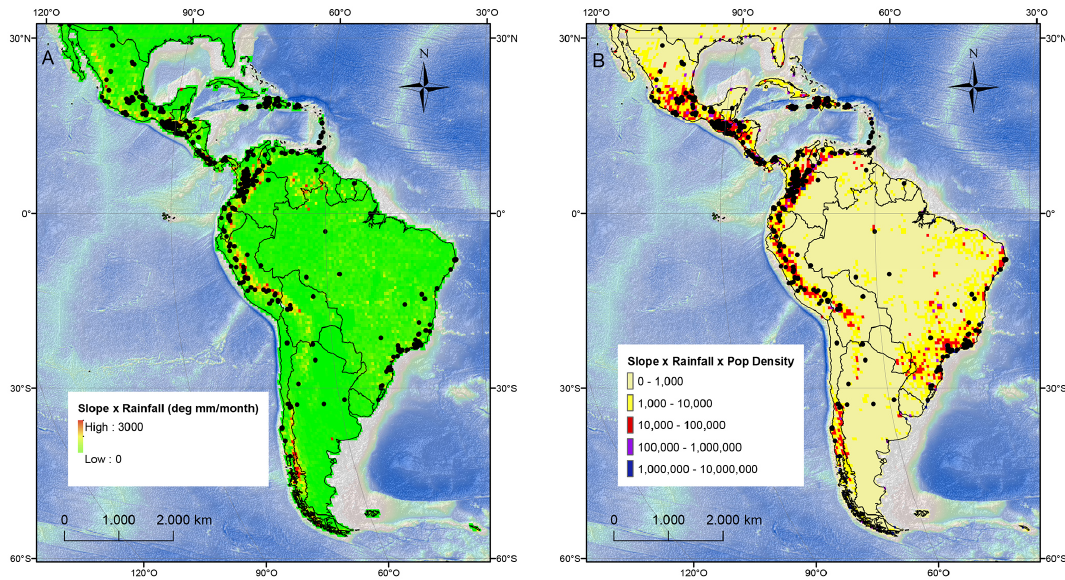
Figure 10. Combined maps of: (a) product of slope and mean annual rainfall and (b) product of slope, mean annual rainfall and population density. Black dots indicate the distribution of fatal landslides.